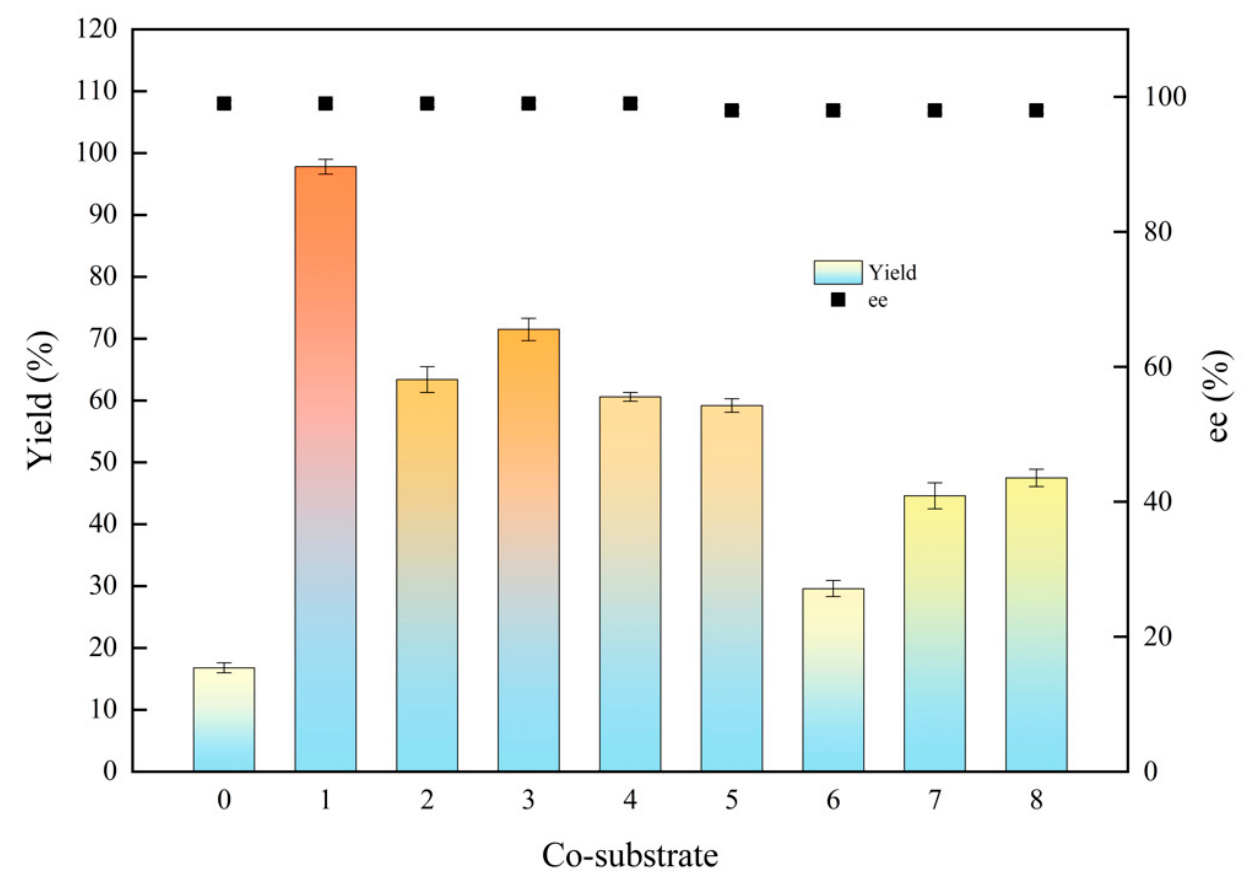
Figure 2. Effects of co-substrates on the biocatalytic reduction. Reaction conditions: 20.0 mL phos- phate buffer (100 mM, pH 6.0), 1.0 g resting cells (DCW), 50 mM 1-chloro-2-heptanone, 15% ( v/v ) various co-substrate, 200 rpm, 30 °C, 24 h. Symbols: 0: control (without co-substrate); 1: isopropanol; 2: ethanol; 3: methanol; 4: glycerol; 5: glucose; 6: sucrose; 7: fructose; 8: lactose.